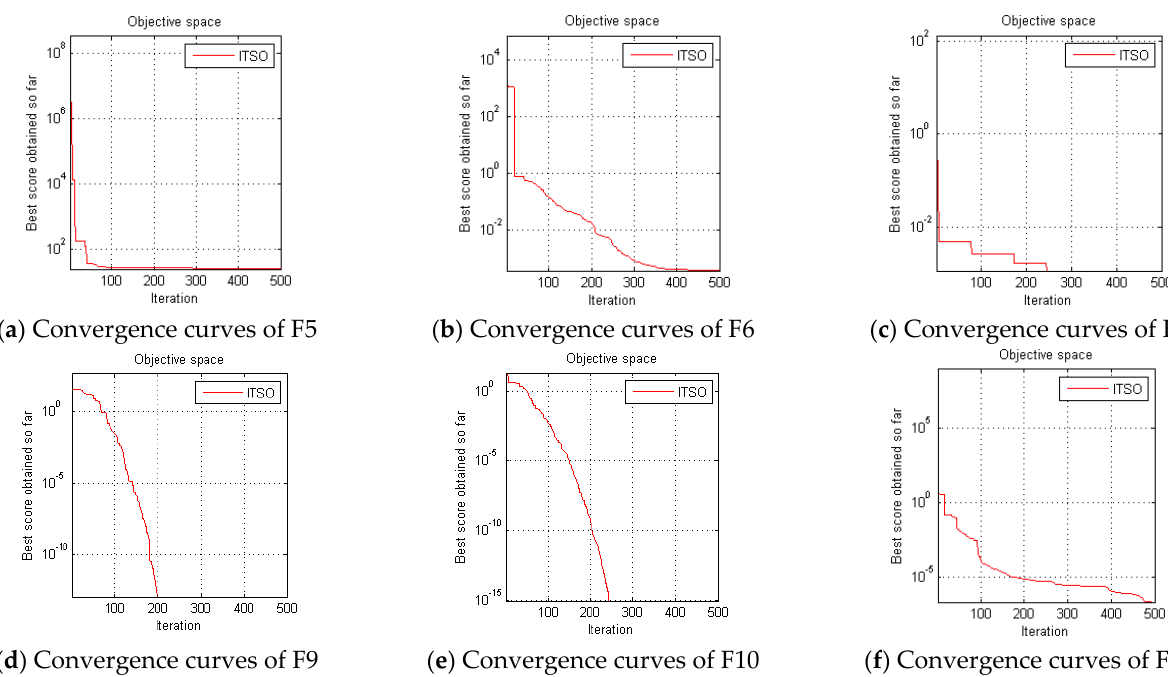
Figure 4. Convergence curves of ITSO on benchmark functions.